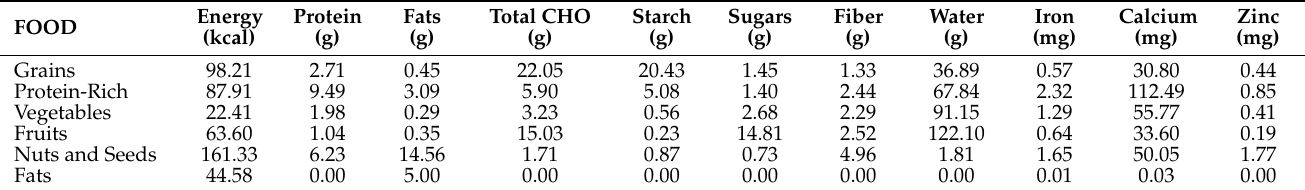
Table 2. Mean energy and macronutrient, fiber, and water content of one average serving of each food